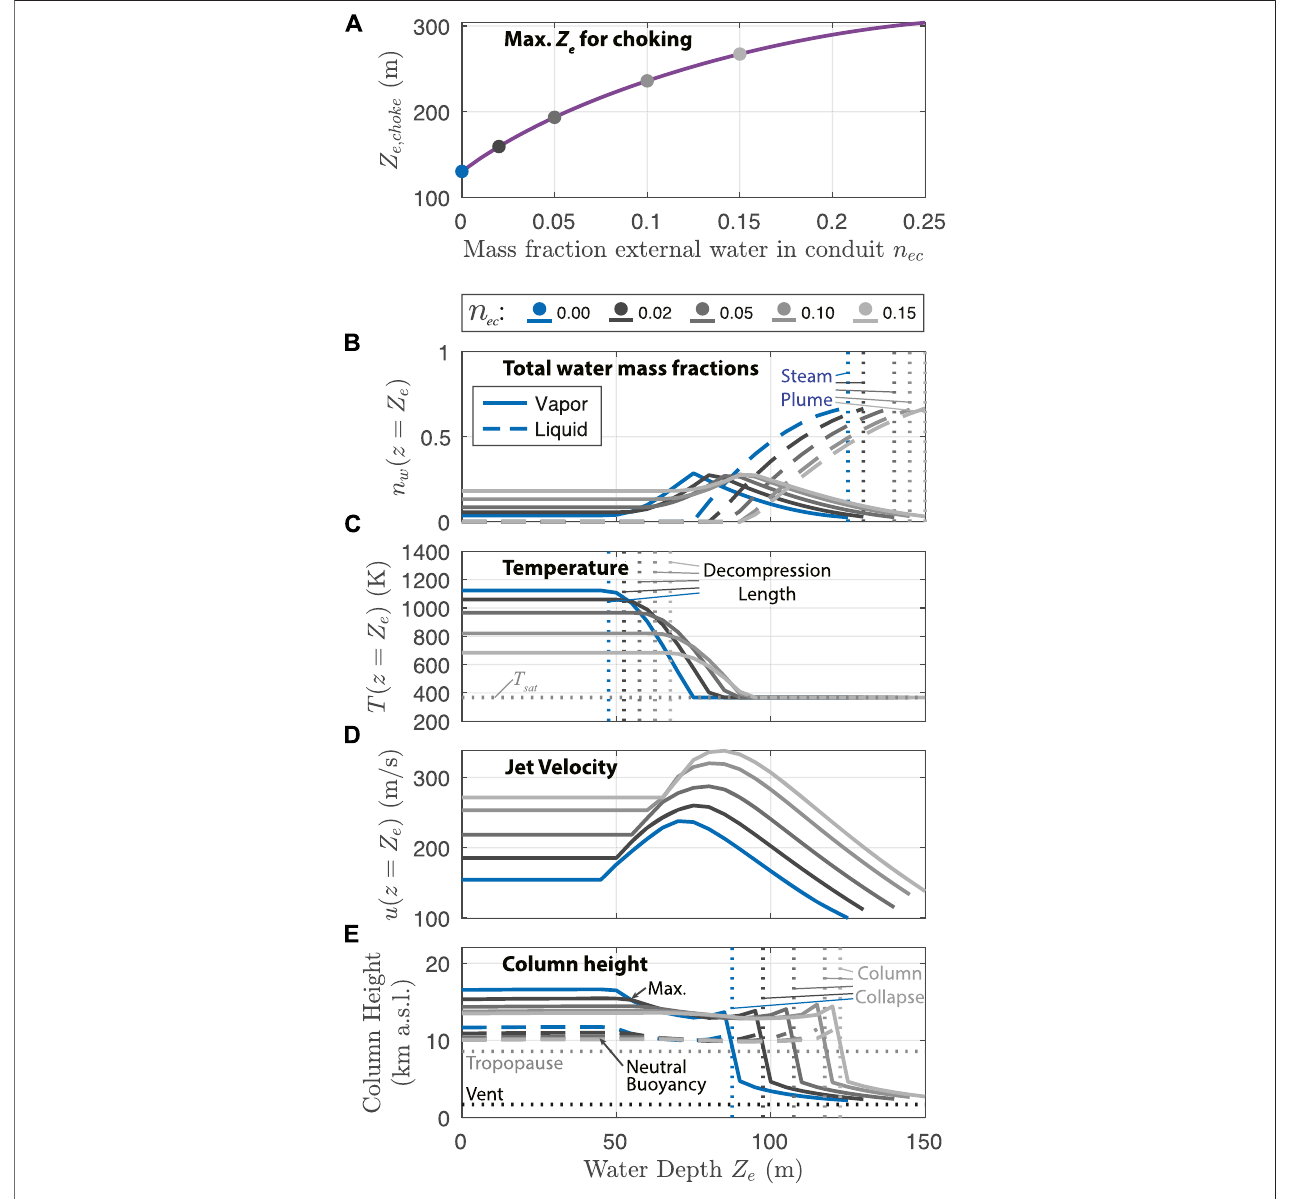
FIGURE 13 | Sensitivity analysis for in fi ltration of a prescribed mass fraction of external water in fi ltrating into the conduit n ec . Simulations use a magmatic mass fl ux of2×10 7 kg/s,andallotherparametersincludingatmosphericpro fi lesareheld fi xedrelativetothe Reference scenario.Ventconditionsarecalculatedaccordingto Eqs. 63 and 65 . (A) Criticalsurfacewaterdepthatwhichhydrostaticpressureexceedsventchokingpressure( Eq.63 )asafunctionofwaterin fi ltrationintotheconduit.Circles highlight the values of n ec used in the simulations shown for panels (B – E) . Panels (B – D) show parameters at the subaerial eruption column source after breach of thewatersurface( z = Z e ). (B) Totalmassfractionsofliquidandvaporwaterphases.Verticaldottedlinesshowthewaterdepththresholdforsteamplumesforeachofthe conduitwaterscenarios. (C) Jetmixturetemperature.Verticaldottedlinesshowthethresholdatwhichdecompressionlengthscale L d isequaltowaterdepth Z e . (D) Jet vertical velocity. (E) Maximum eruption column height (solid lines) and level of neutral buoyancy (dashed lines). Vertical dotted lines show the water depth threshold for column collapse.